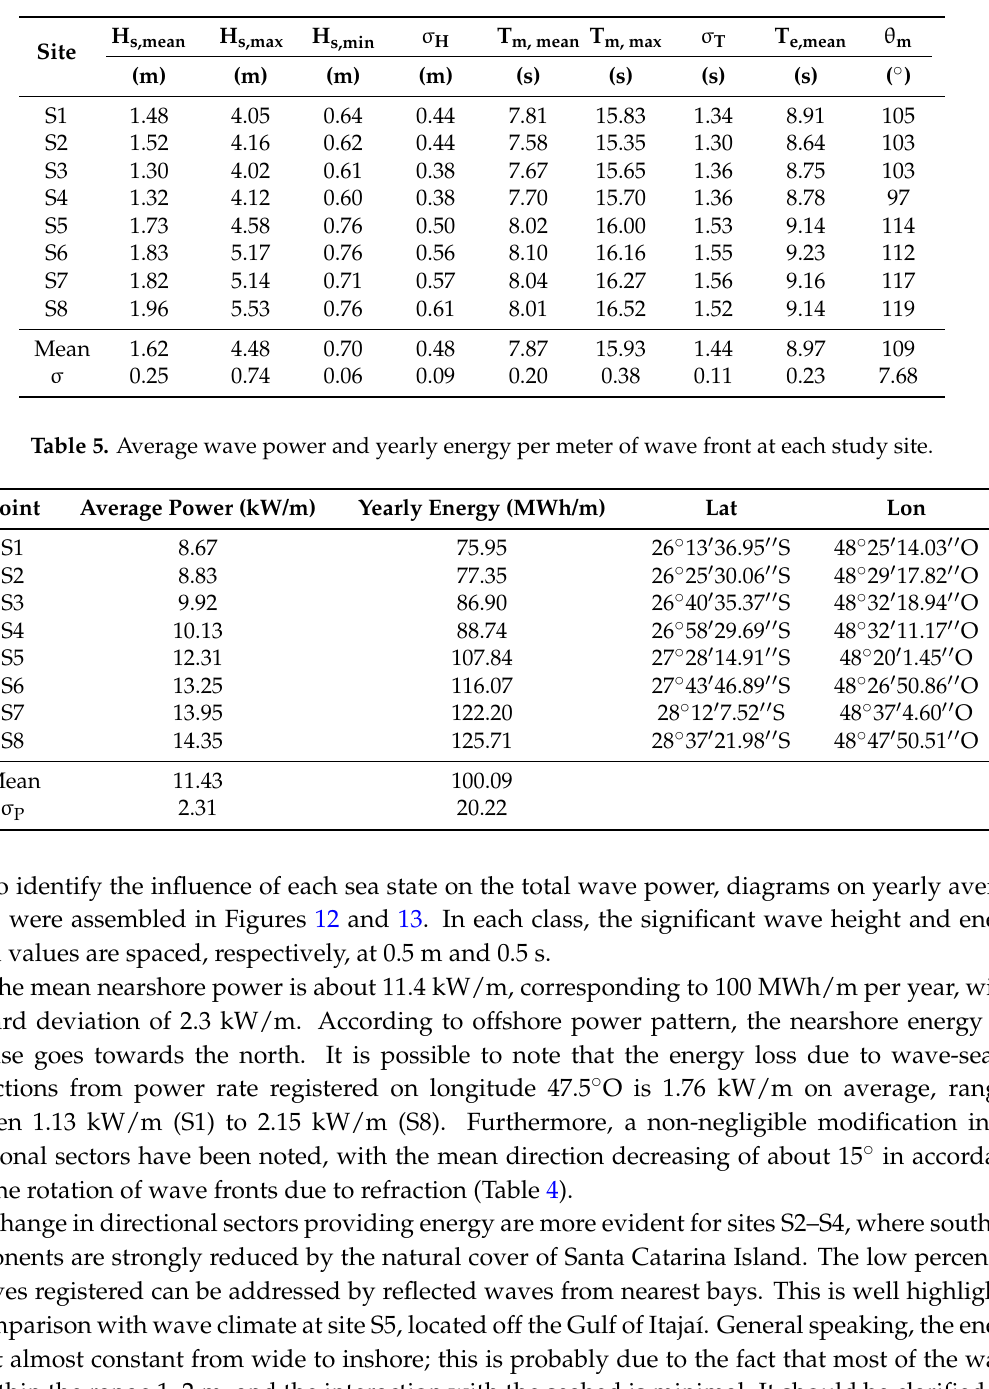
Table 4. Main wave climate parameters at each study site.